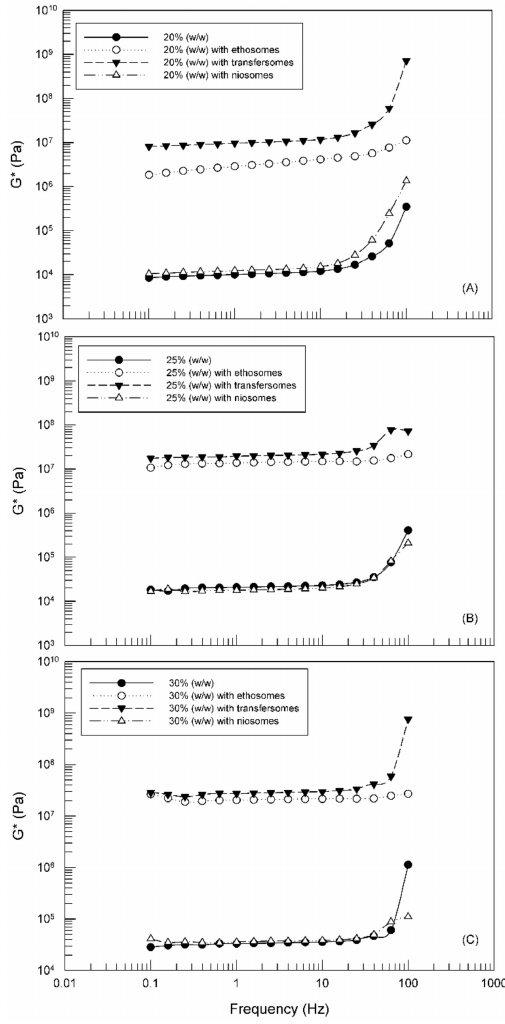
Figure 8. Complex shear modulus ( G* ) versus Frequency for 20% Poloxamer 407 ( A ), 25% Poloxamer 407 ( B ) and 30% Poloxamer 407 ( C ) with and without TDDSs. The illustrated results were representative of three independent